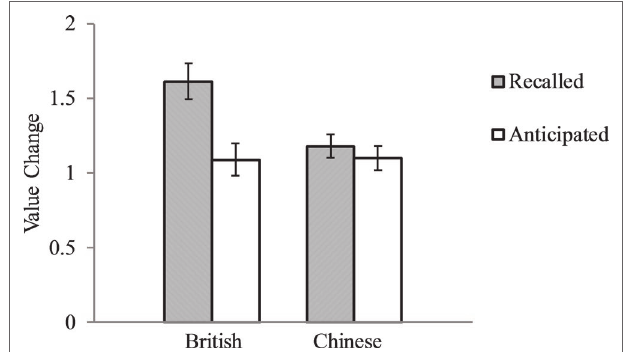
FIGURE 2 | British and Chinese recalled value changes in the past 10 years and their anticipated value changes in the future 10 years. Error bars represent standard errors.